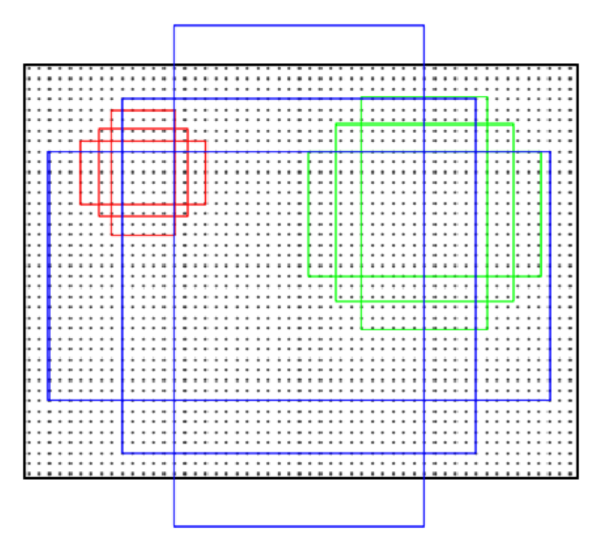
Figure 6. Diagram of the nine kinds of anchors.